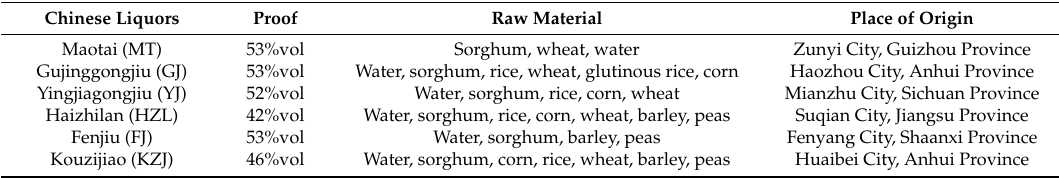
Table 1. Details of Chinese